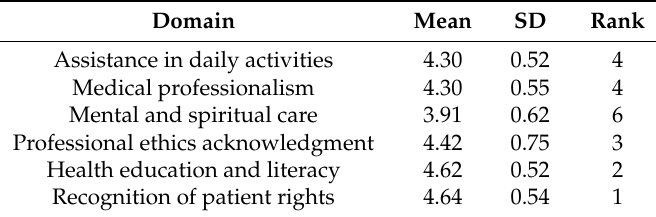
Table 2. Domains of competency level in disability nursing